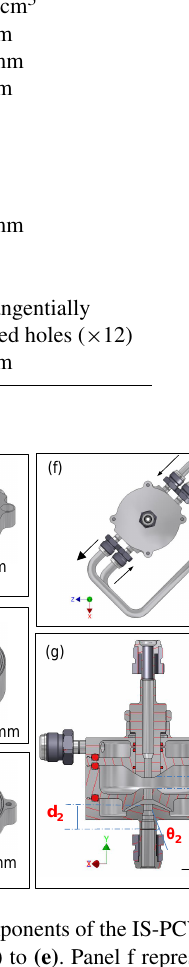
Table 1. Geometrical parameters of the traditional PCVI and the IS-PCVI derived from the Autodesk Inventor 3-D computer-digitized design. Parameter PCVI IS-PCVI (Boulter et al., 2006) (this study) Total inner air volume 6.2cm 3 193.7cm 3 Nozzle outlet-to-collector inlet length ( d 1 ) 1.5mm 8.5mm